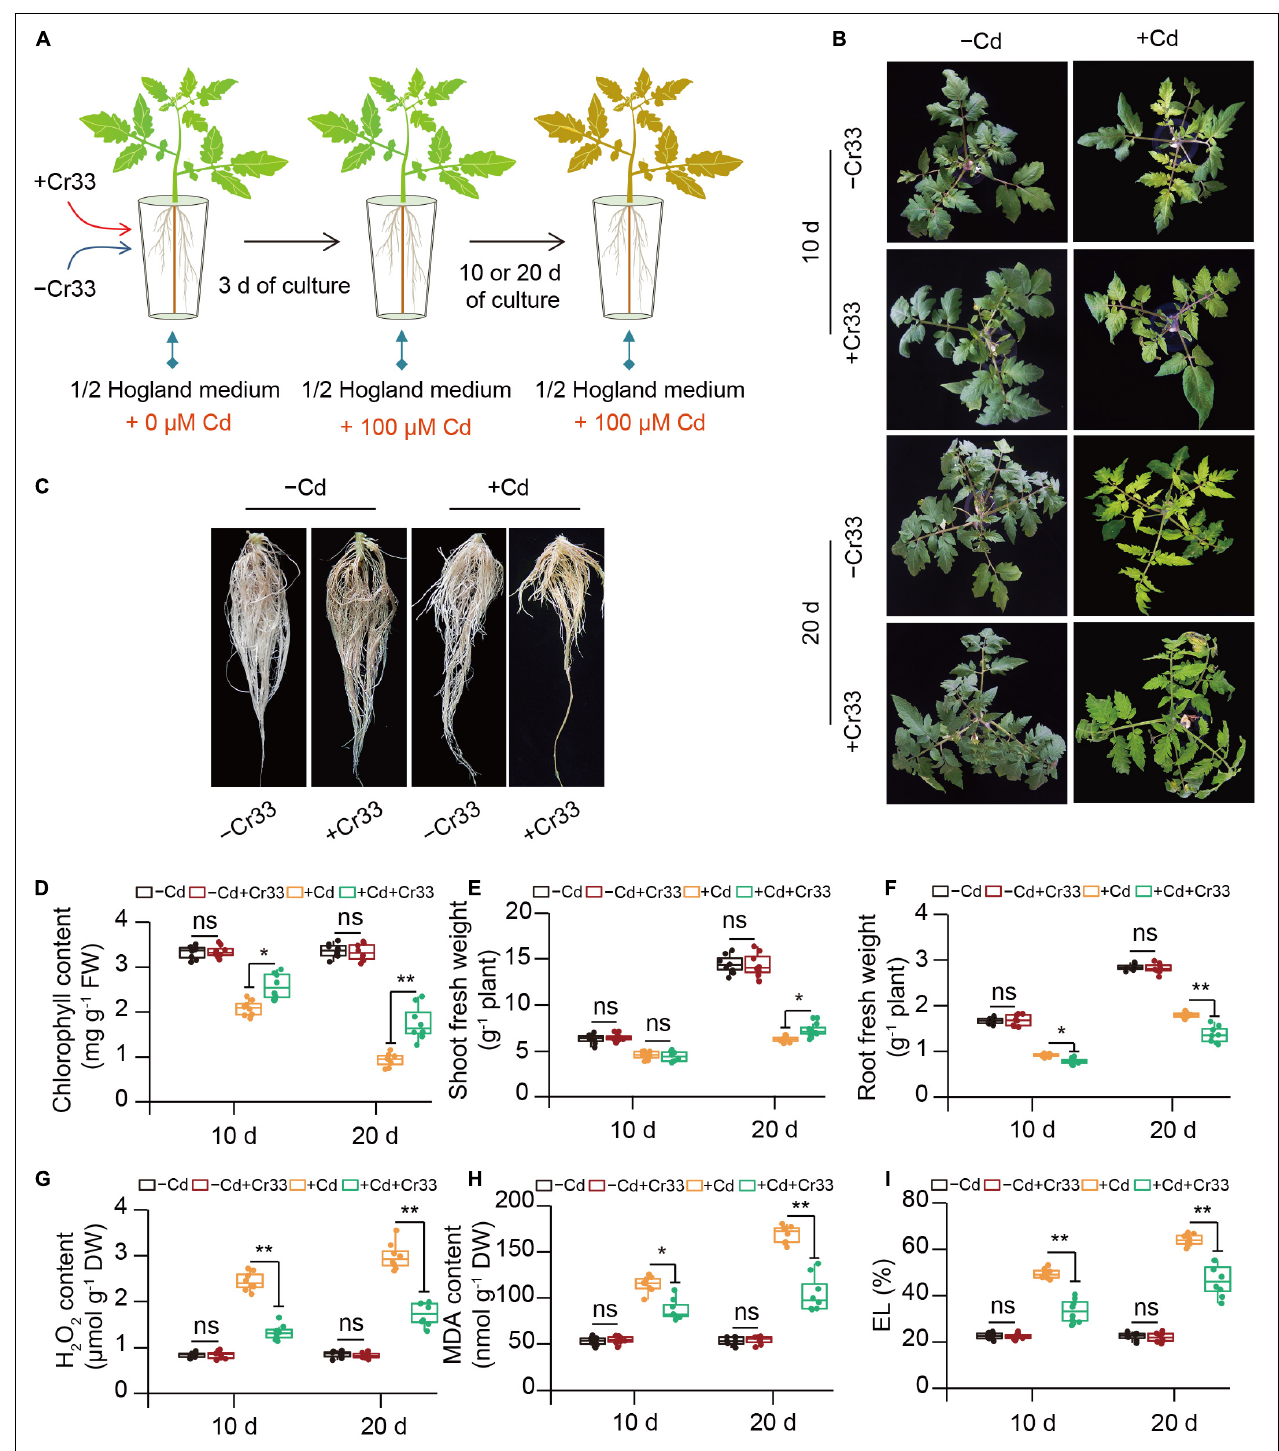
FIGURE 2 | Root inoculation with L. fusiformis Cr33 ameliorated Cd stress in tomato plants. (A) Three-weeks-old tomato plants cultured in the split-root systems were inoculated with or without Cr33 for 3 d. Then, these plants were exposed to 0 or 100 µ M Cd with or without Cr33 for 10 and 20 d, respectively. These plants were used to analyze shoot phenotypes (B) , root growth after 20 d of culture (C) , chlorophyll content (D) , shoot (E) and root (F) fresh weight, H 2 O 2 content (G) , and MDA (H) and EL (I) . Asterisks indicated significant differences between the control and inoculated plants ( n = 8 biological replicates) using Student’s test (ns, not significant; * p < 0.05; ** p <